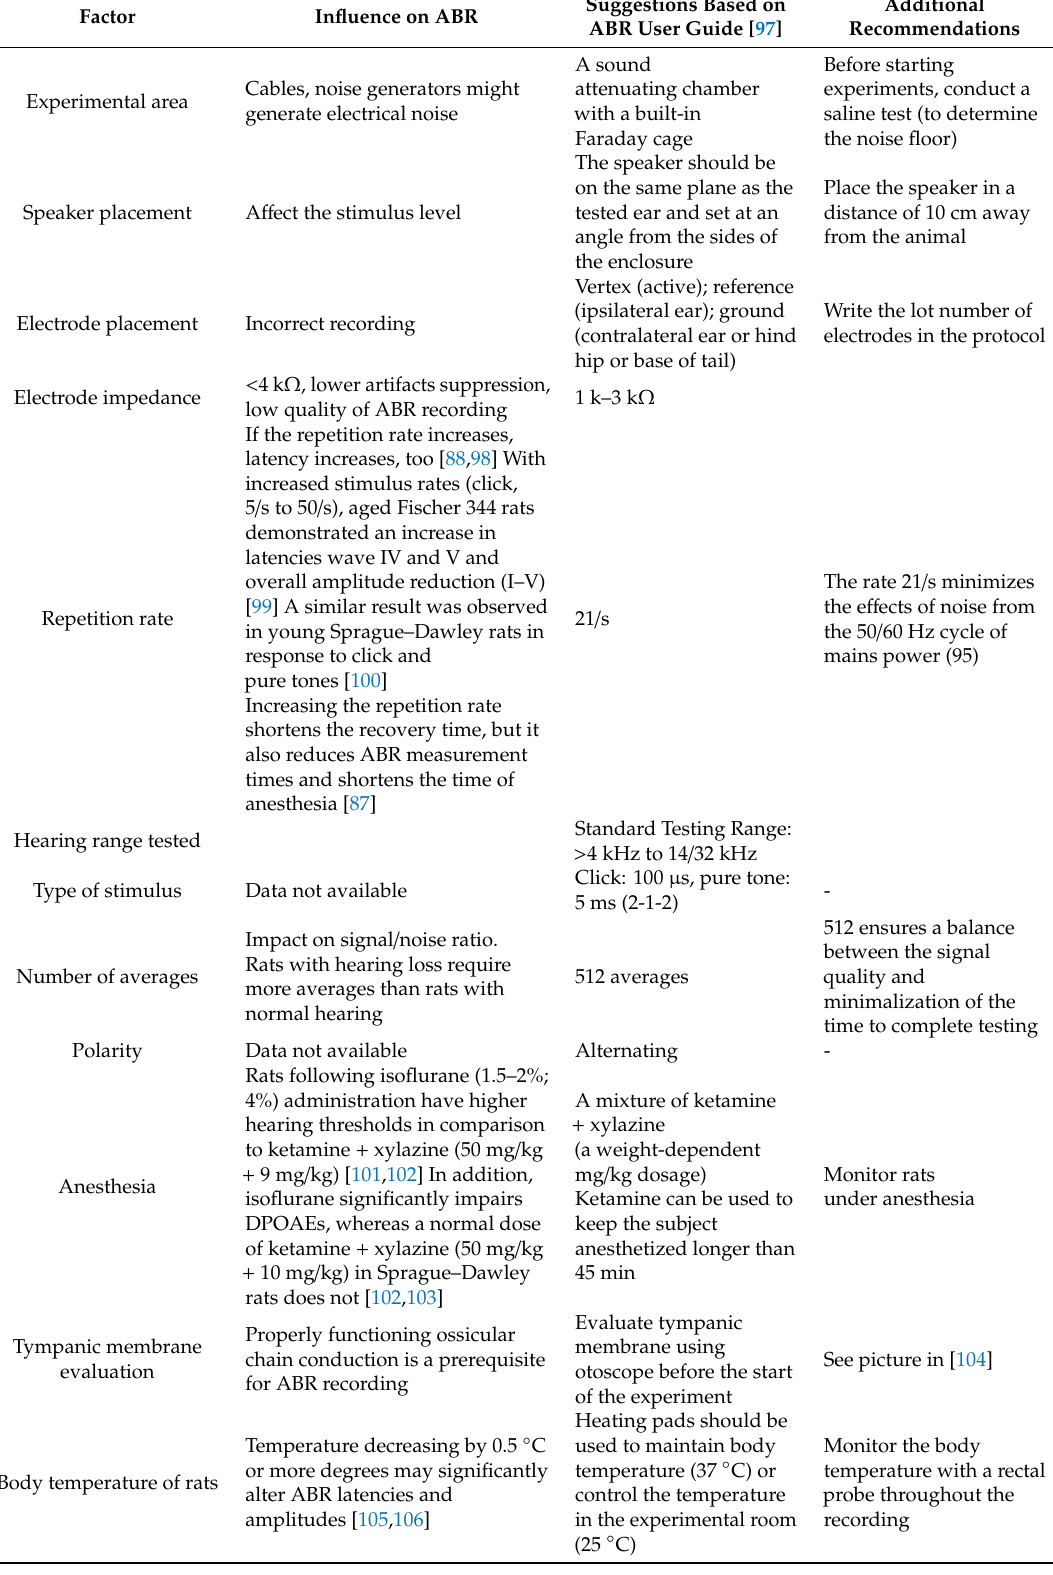
Table 6. Factors possibly influencing ABR